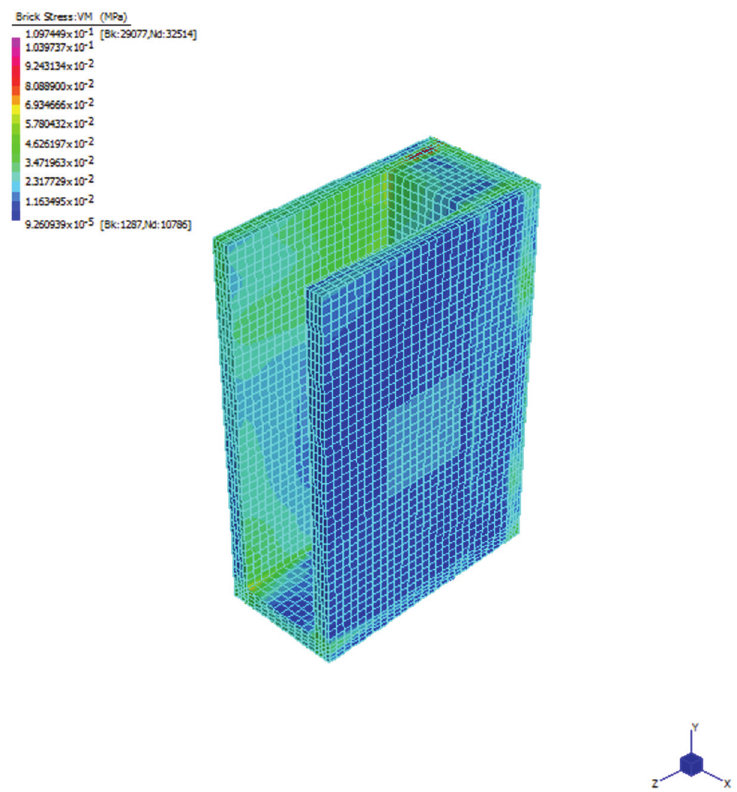
Fig. 10: Stress in the silicone from the Connection Forces